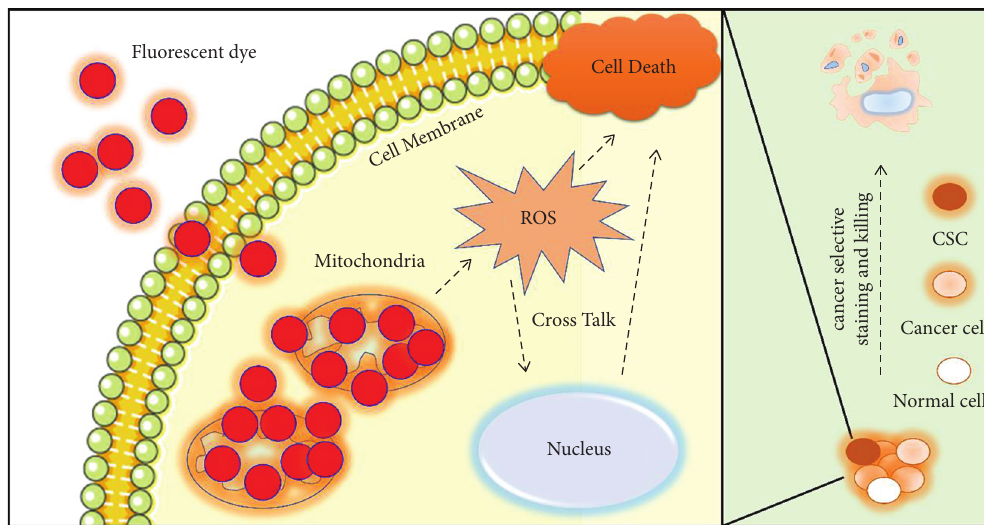
Figure 7: A working model for the application of the fluorescent dye in